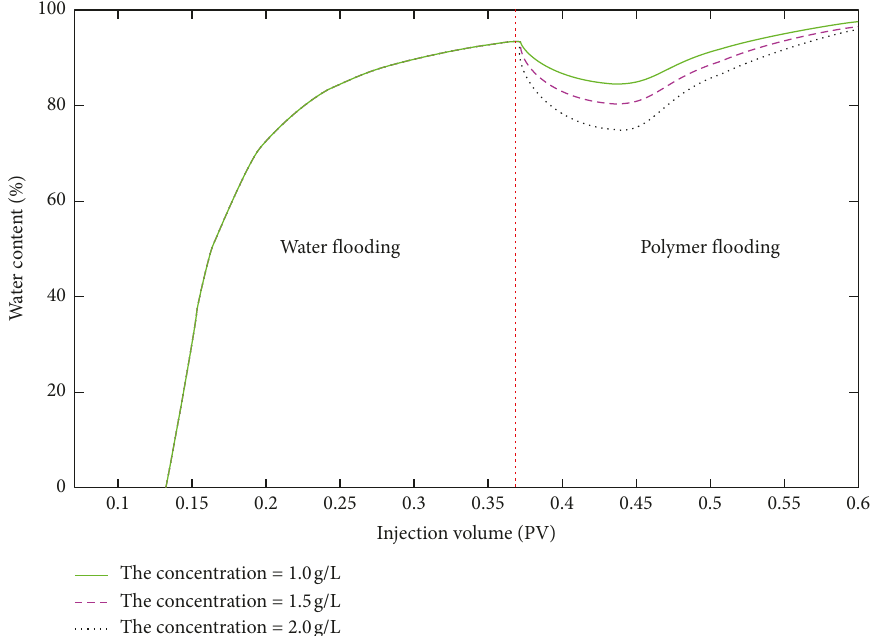
Figure 7: Water content with different polymer